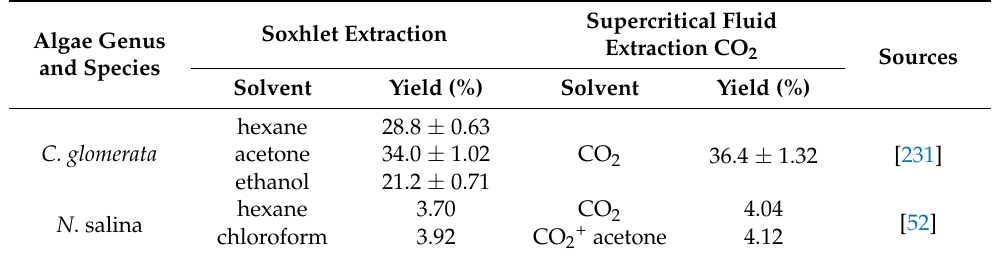
Table 3. Total fatty acid content (wt% in dry extract) with supercritical fluid and Soxhlet extractions. Algae